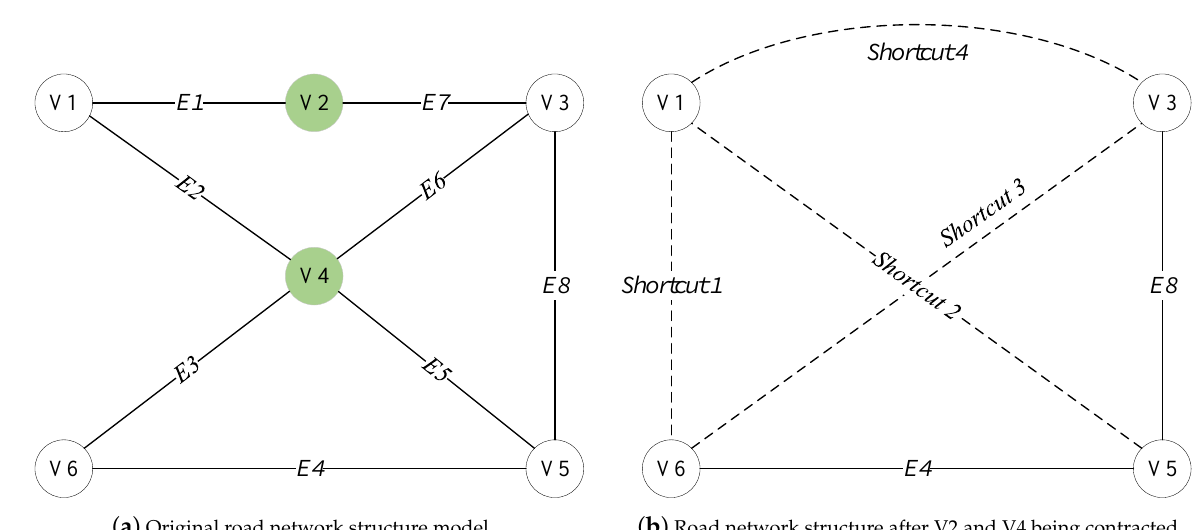
Figure 11. Schematic diagram of contraction hierarchical algorithm. ( a ) Road network structure without vertex contraction algorithm. ( b ) Road network structure after vertex